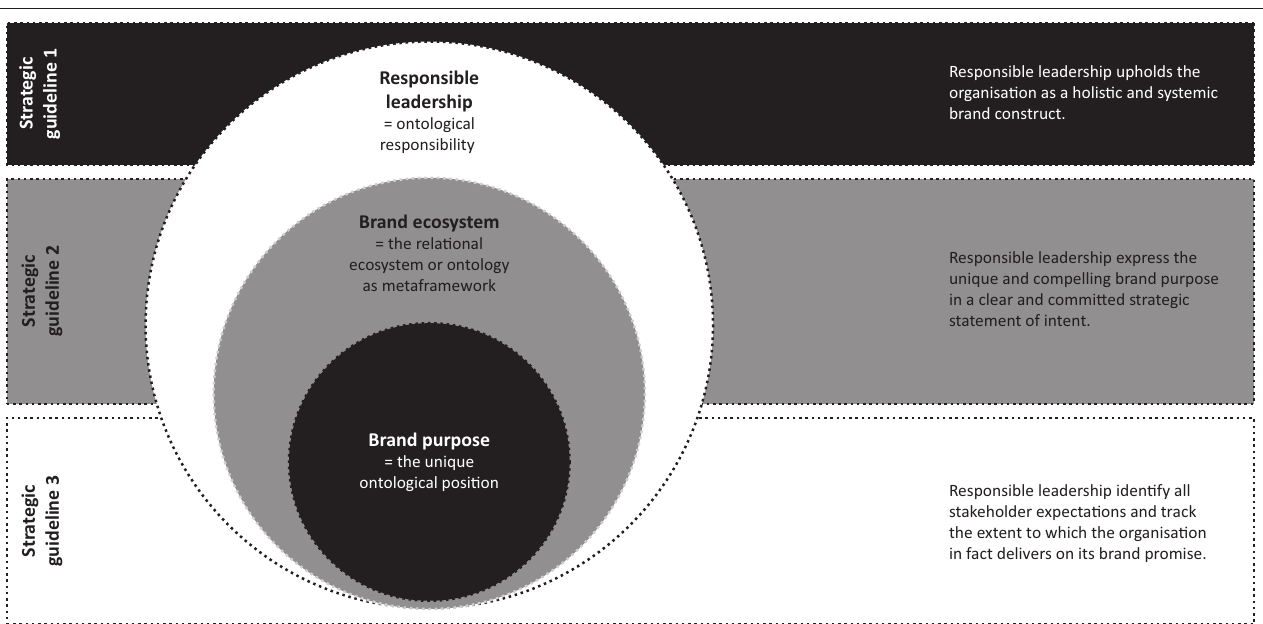
FIGURE 4: Conceptual model: strategic guidelines as practices for operationalising responsible leadership through purpose-driven brand